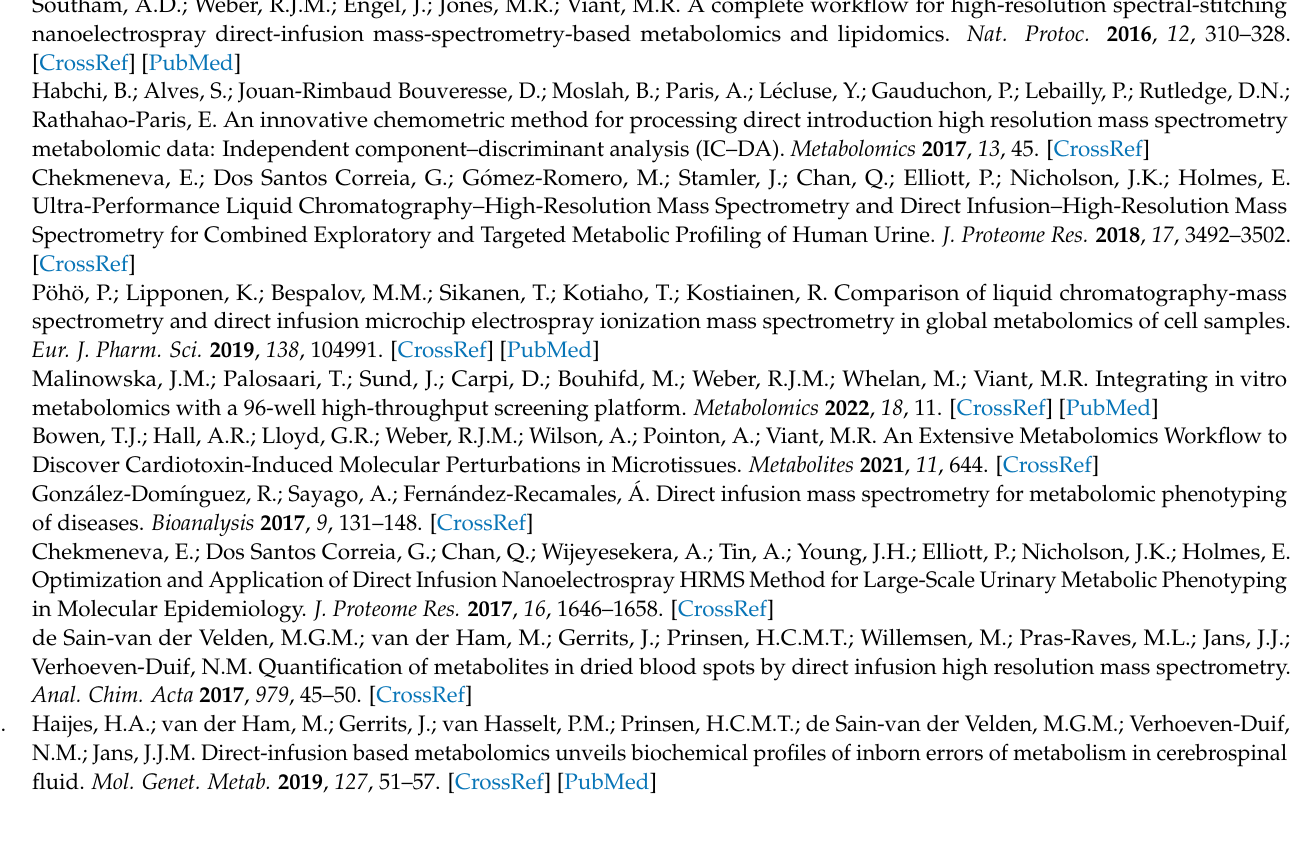
of metabolites standards; Table S2: Information of internal standards; Table S3: Clinical information of participants; Table S4: Information of 10 standards for linearity; Table S5. Reactions types; Table S6. Significantly changed features between healthy and T2D